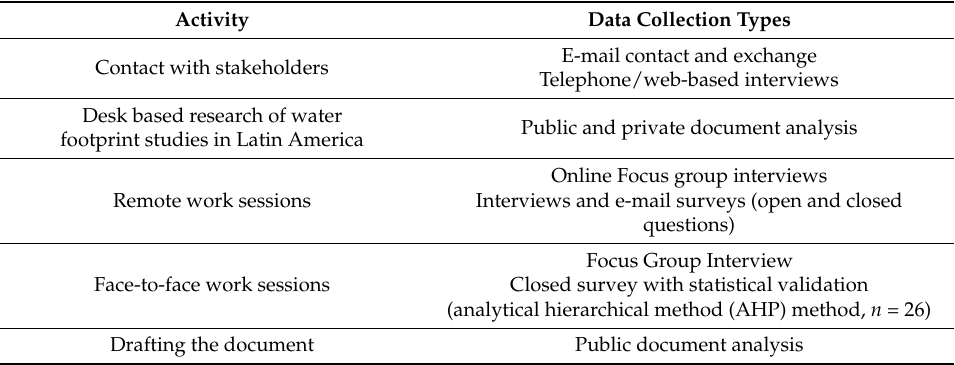
Table 1. Research